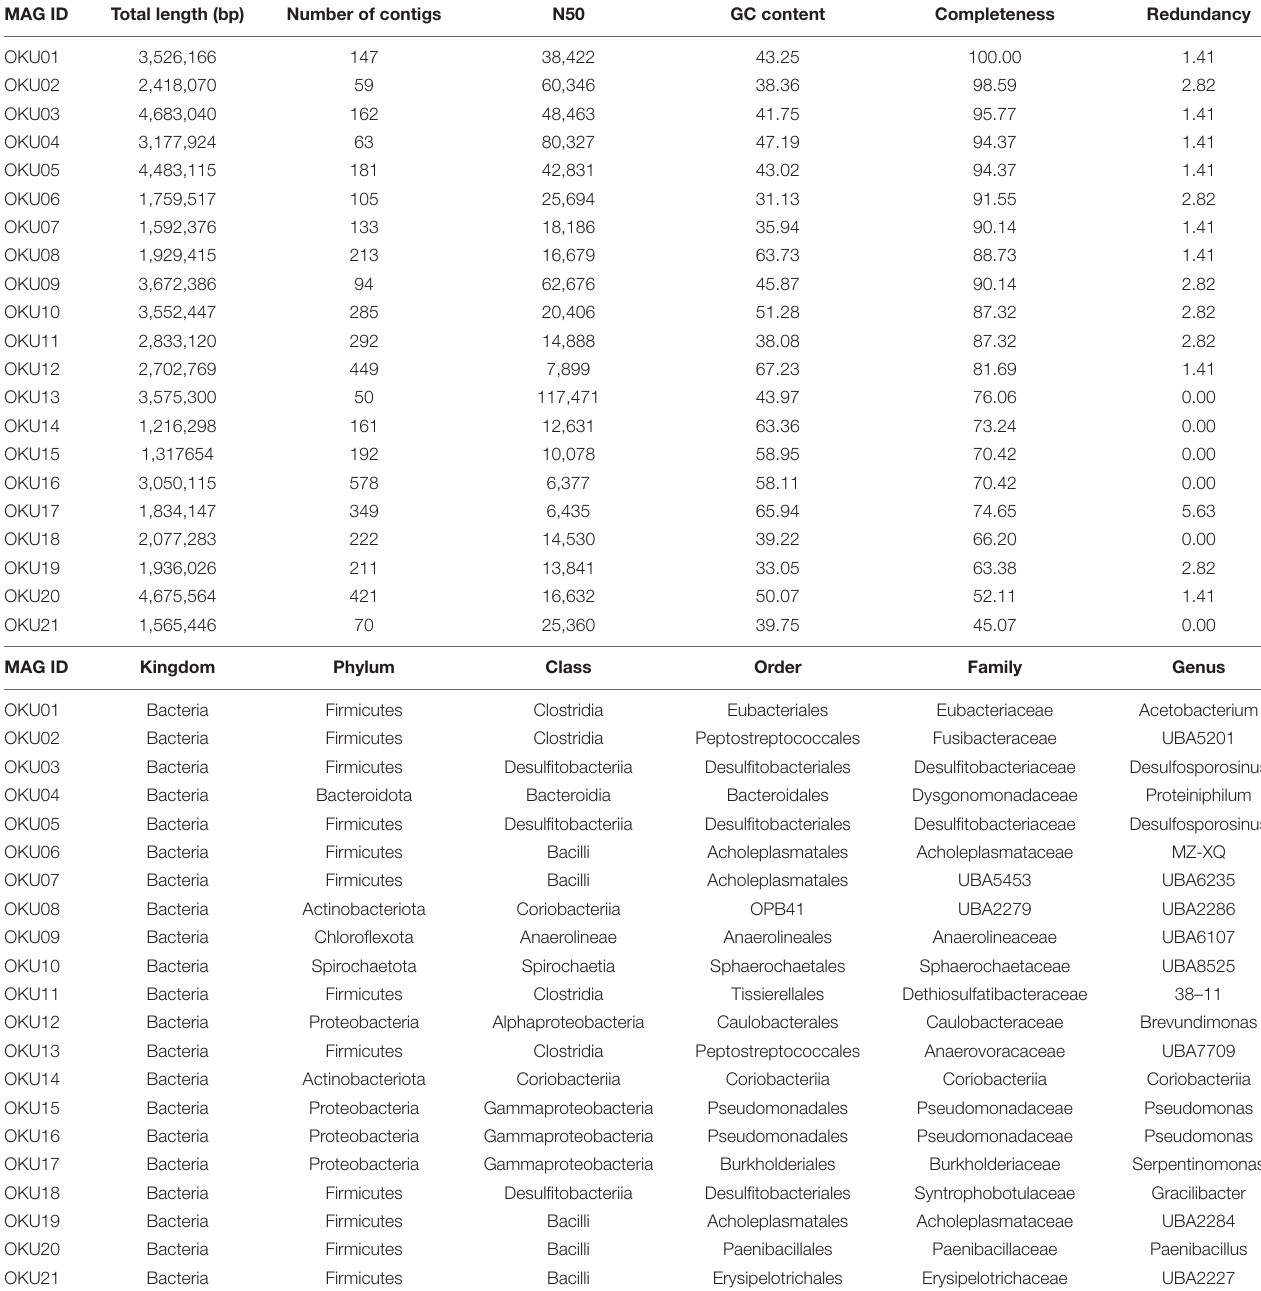
TABLE 2 | Metagenome assembled genomes.